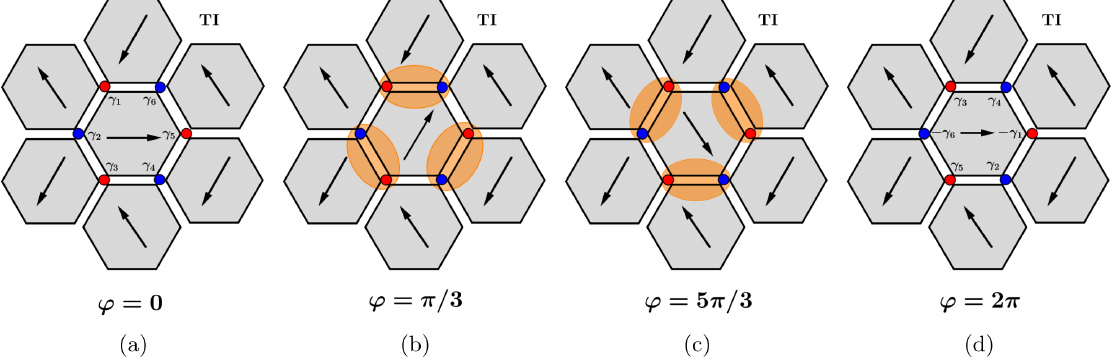
FIG. 4. Schematic of a 2 π phase slip on the central superconducting island in a hexagonal superconducting array on a TI surface, with the phase of the central island indicated in each panel. When the phase difference between neighboring islands is π , the pair of Majorana fermions on the shared edges couple [4] as indicated. The 2 π phase slip permutes the Majorana fermions as shown, leading to the transformation in Eq.